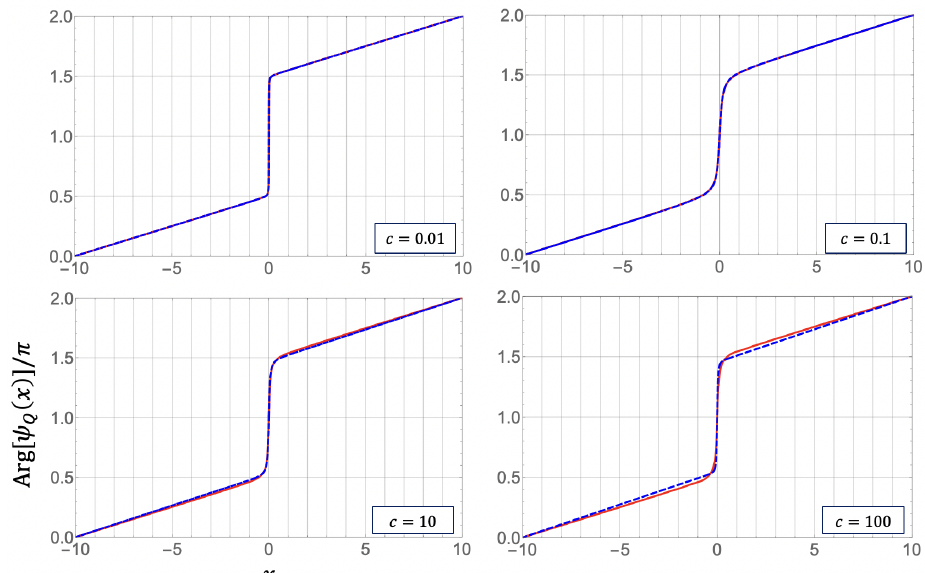
Figure 5. Phase profiles arg [ ψ Q ( x )] / π for N = L = 20, and c = 0.05, 0.1, 10, and 100 (red solid curves) and the corresponding elliptic solutions (blue dashed curves). The corresponding quantum state is given by Equation (31), which has J = 1. In the panels of c = 0.01 and 0.1, the red solid curves completely agree with the blue dashed curves,